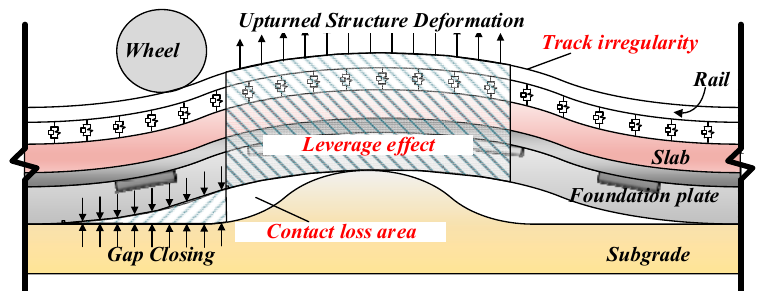
Figure 16. Influencing mechanism of frost heave on vehicle-track coupling system.